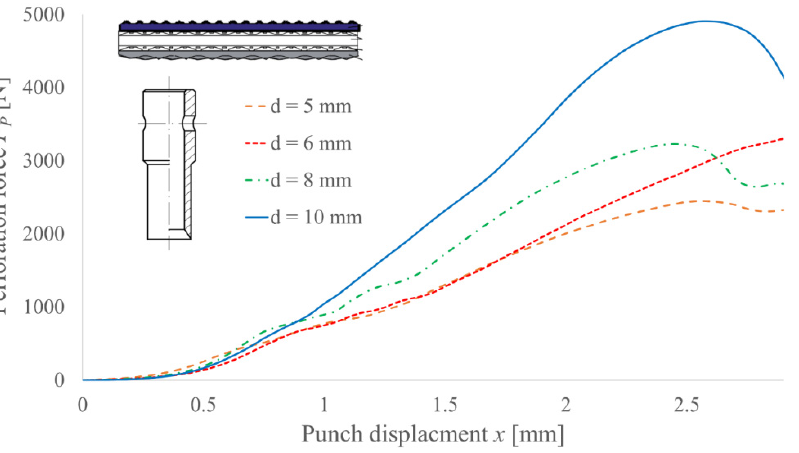
Figure 13. Experimental results of the perforation force measurement for PI punches with angle of the blade β = 30° and various diameters d for TFL10S belt.